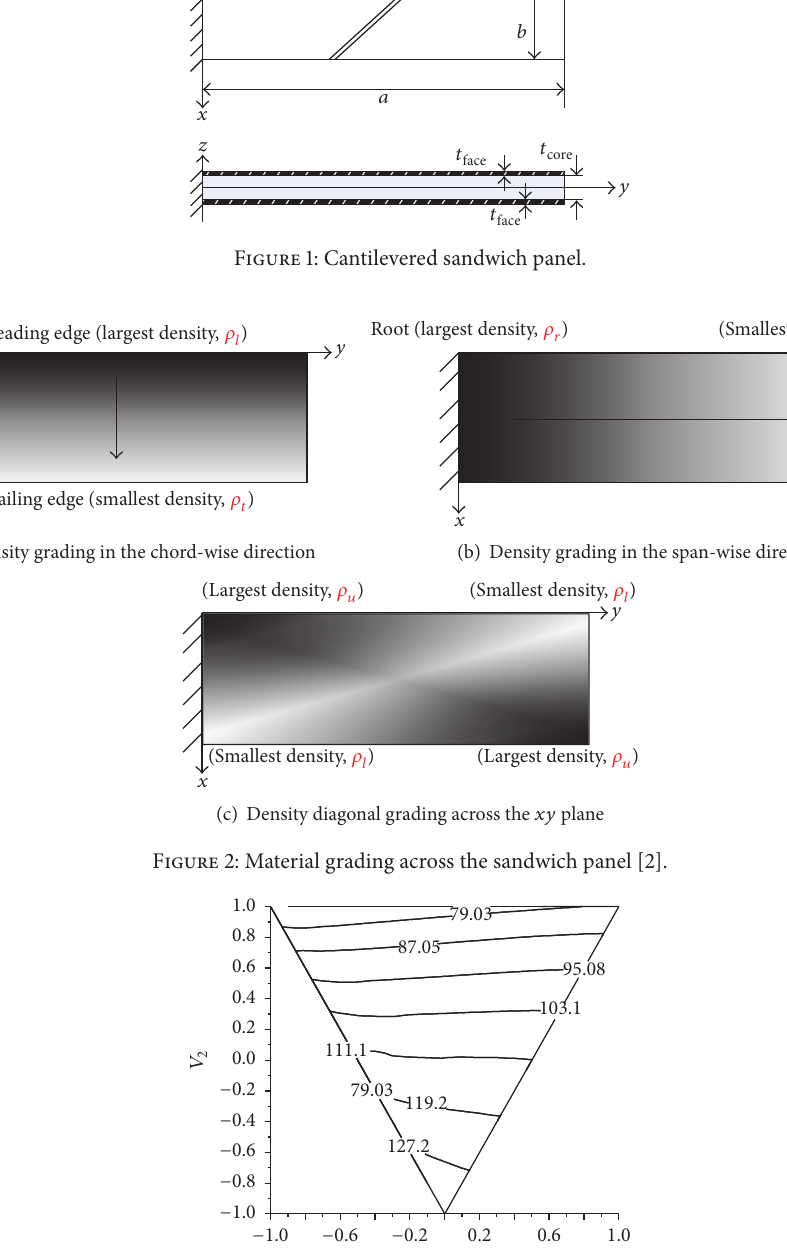
of the flutter speed for both sets. This is because the flutter characteristic is dependent on several other factors: wing sweep, aspect ratio, and the stiffness distribution. However, it shows that the proper gradient of the foam has the potential the flutter speed of the sandwich